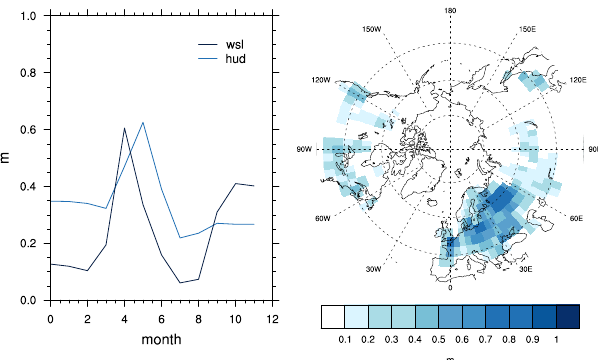
kgC m -2 (wetland fraction)